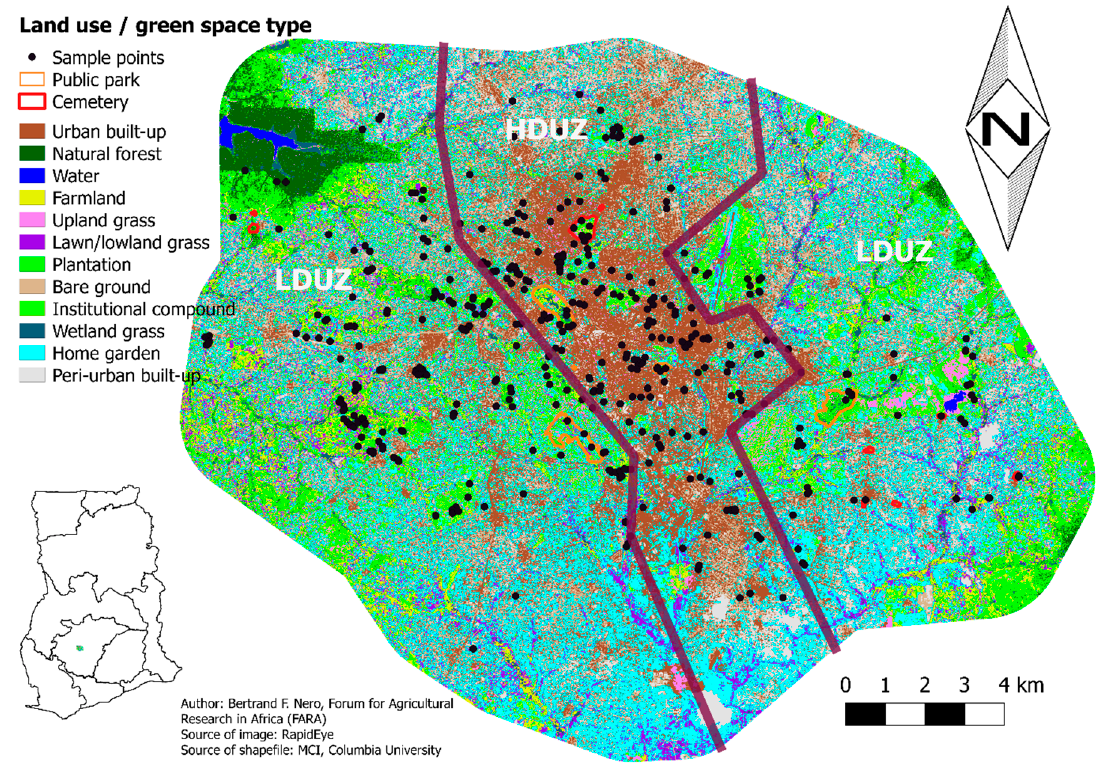
Figure 1. Urban green space map of Kumasi showing the two urban zones. HDUZ—high density urban zone and LDUZ—low density urban zone.